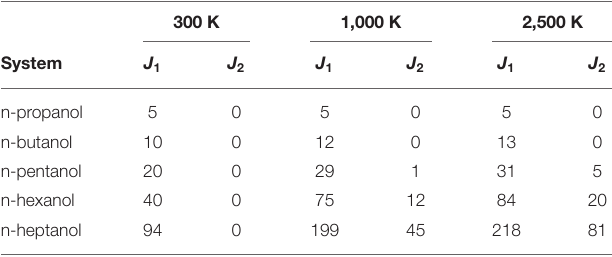
TABLE 3 | Minimum number of HL conformer needed to achieve 300, 1,000, and 2,500 K.